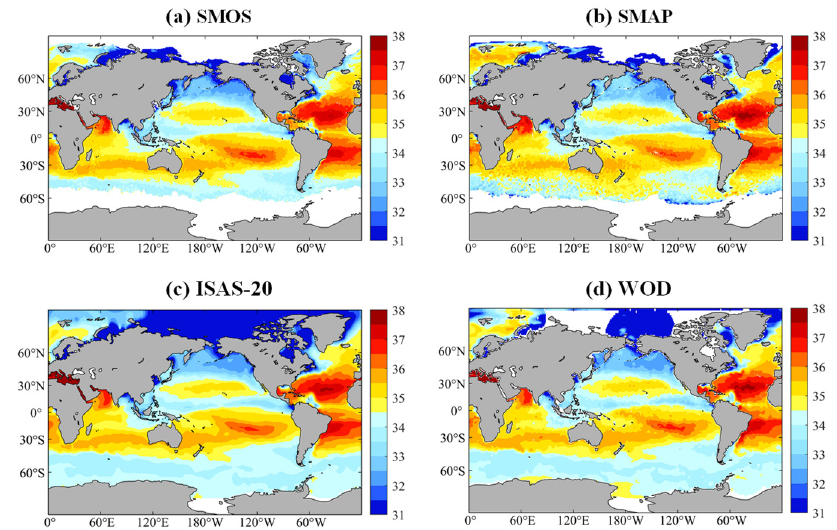
Figure 7. Global SSS maps for ( a ) Soil Moisture and Ocean Salinity (SMOS), ( b ) Soil Moisture Active- Passive (SMAP), ( c ) In Situ Analysis System (ISAS-20) and ( d ) WODSSS in August 2017. The unit is in the Practical Salinity Unit.